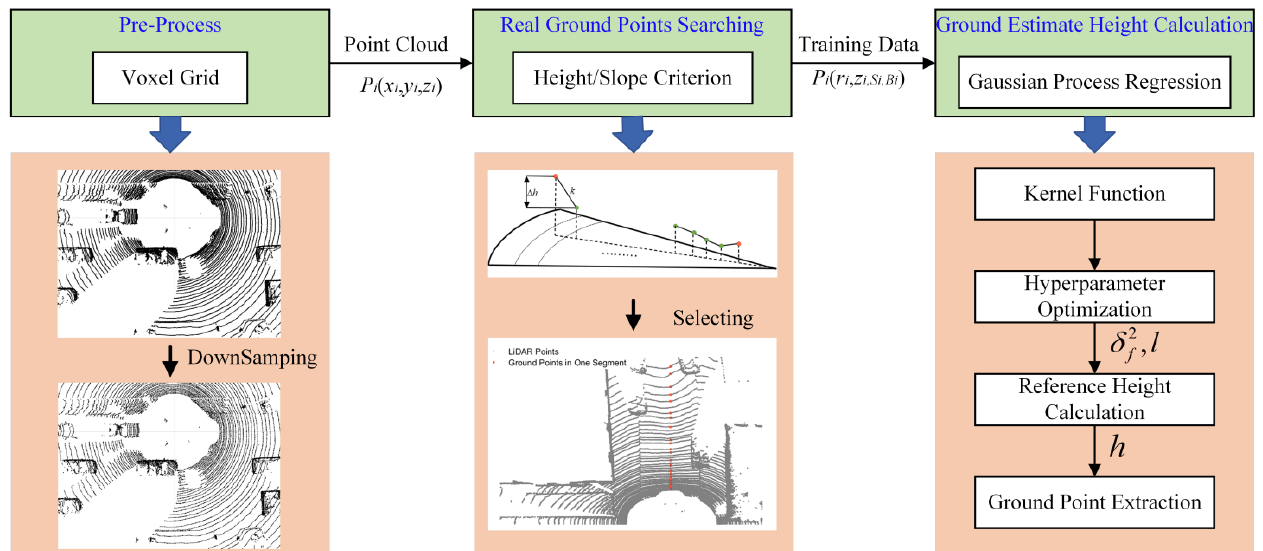
Figure 1. The flow chart of this paper.